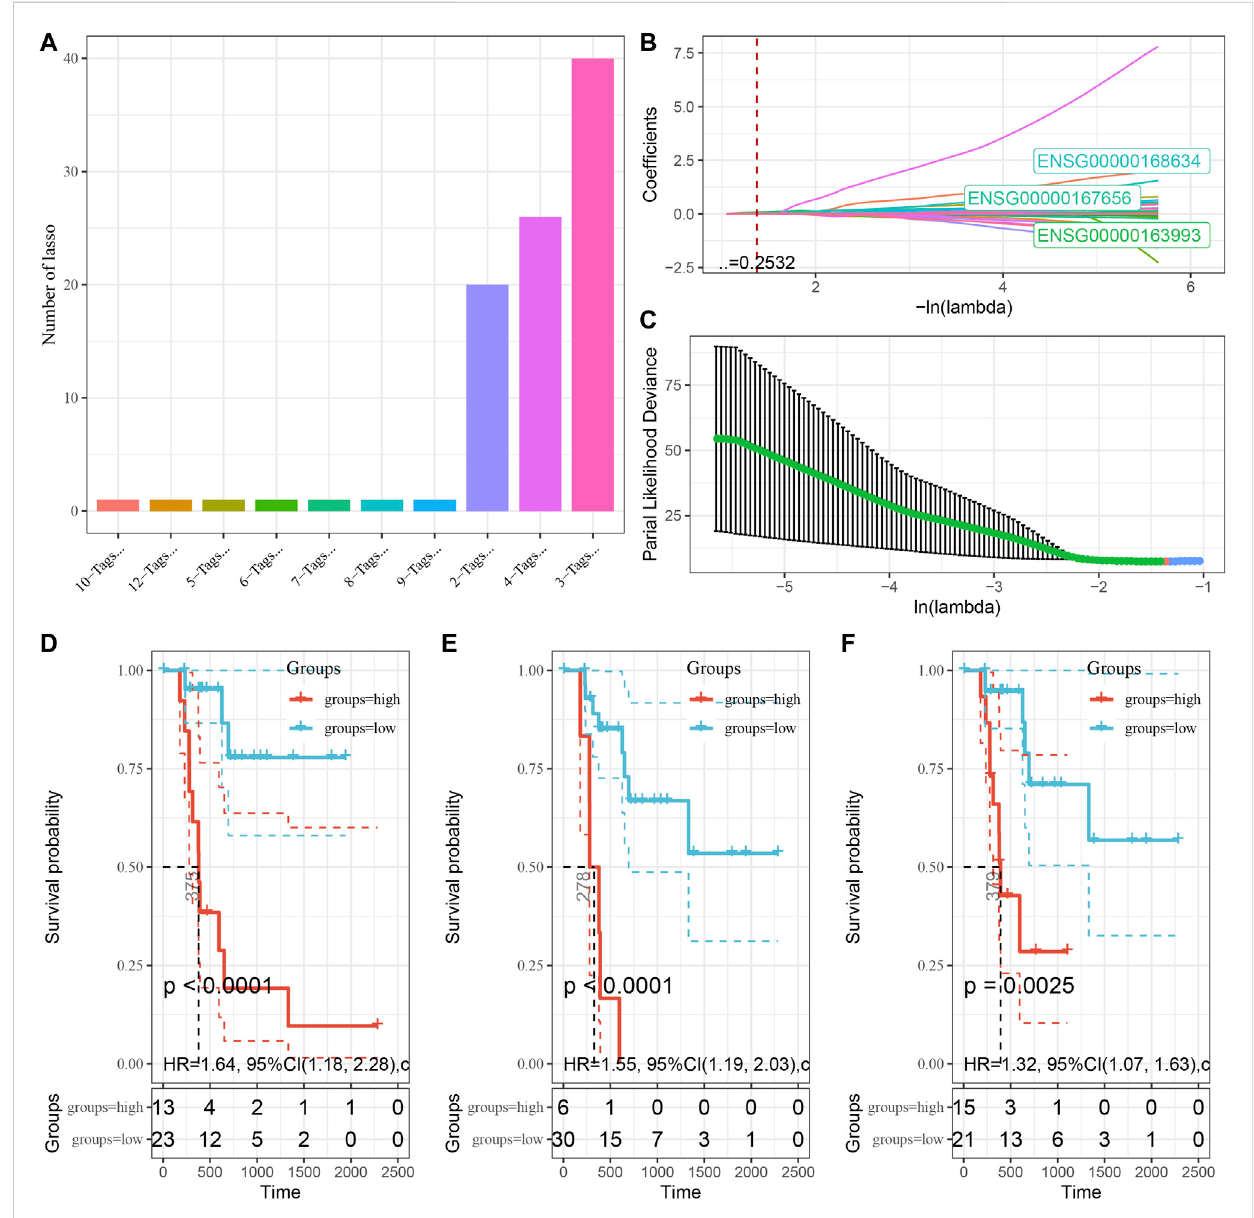
FIGURE 7 Establishment of prognostic gene signature associated with DMEG. (A) Frequency of individual gene combinations for one thousand lasso regressions. (B) Coef fi cient change trajectories of individual genes under different lambda. (C) Standard deviation distribution of the models under different lambda. (D) Prognostic KM curves of S100P in high and low expression groups. (E) Prognostic KM curves of LY6D in high and low expression groups. (F) Prognostic KM curves of WFDC13 in high and low expression